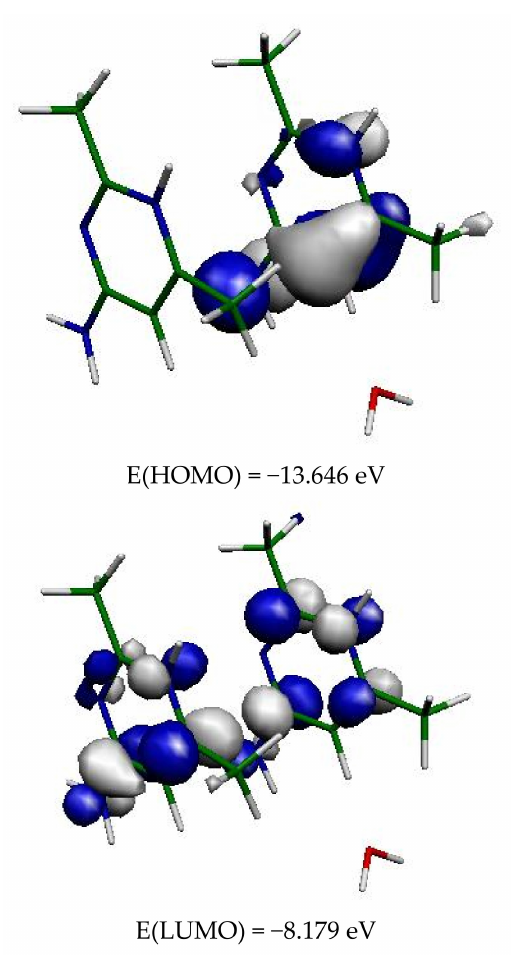
Figure 12. Frontier orbitals of the two organic cations in ( 2